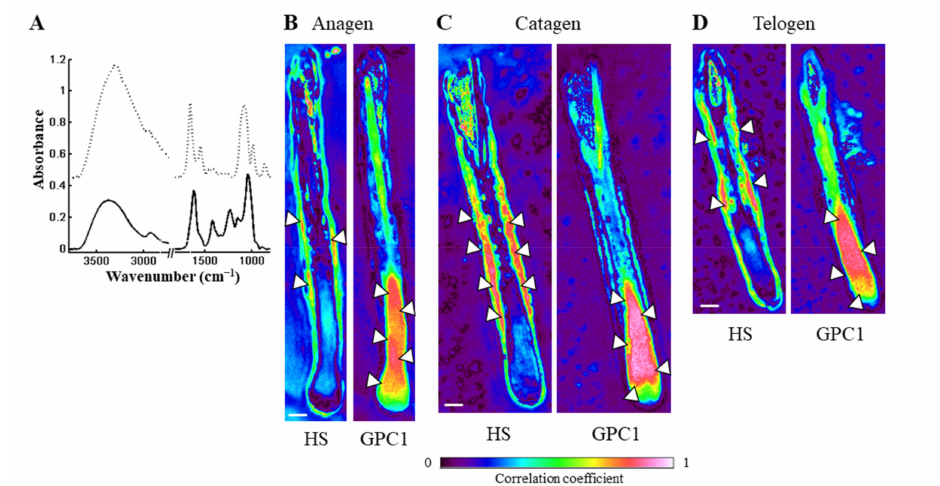
Figure 5. Contribution of the heparan sulfate GAG chain and glypican-1 in a hair follicle. ( A ) Mean spectra of standard HS (continuous line) and GPC1 (dashed line). ( B – D ) IR correlation maps of hair follicles in the anagen A1 ( B ), catagen C1 ( C ), and telogen T1 ( D ) phases using mean spectra from standard heparan sulfate (left) and human recombinant glypican-1 (right). HS, heparan sulfate; GPC1, glypican-1. Arrowheads indicate high level of correlation. Scale bar: 100 µ